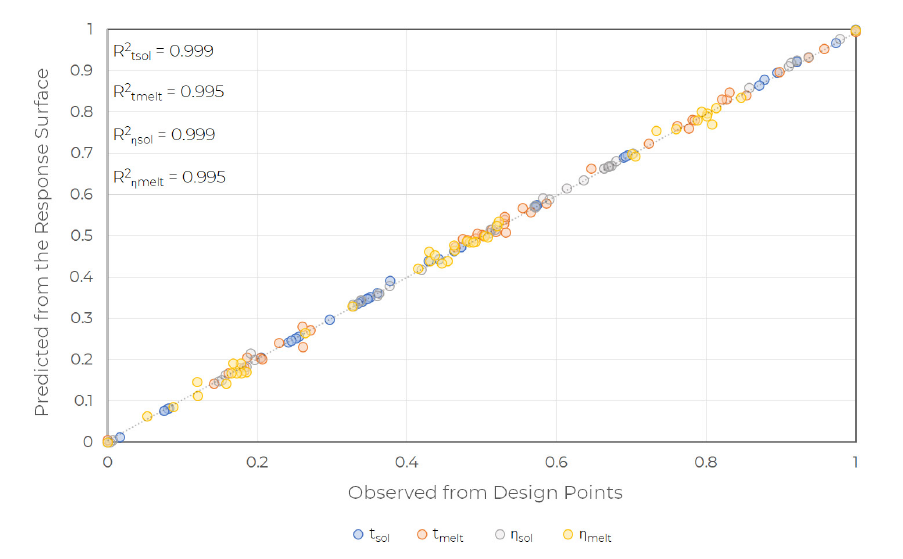
Figure 12. Verification of response